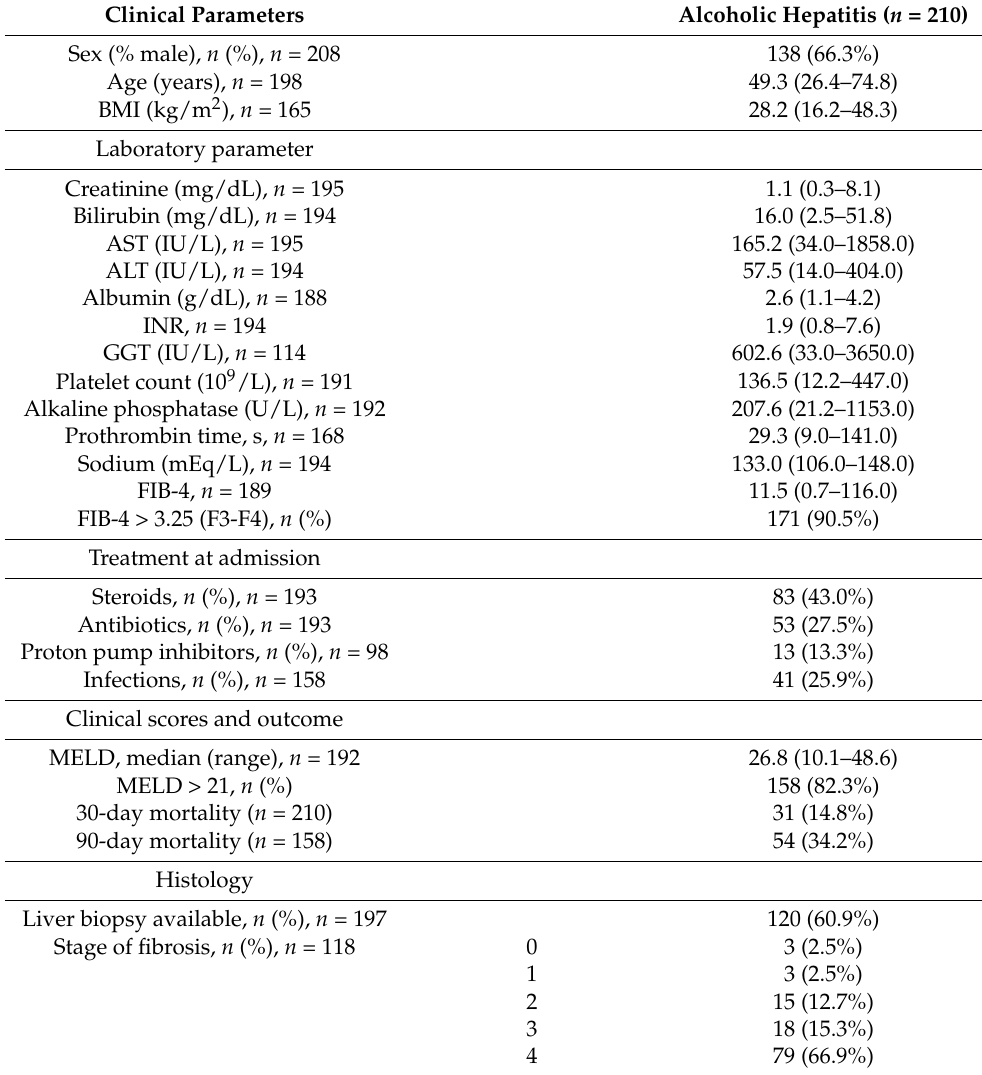
Table 1. Characteristics of patients with alcoholic hepatitis.